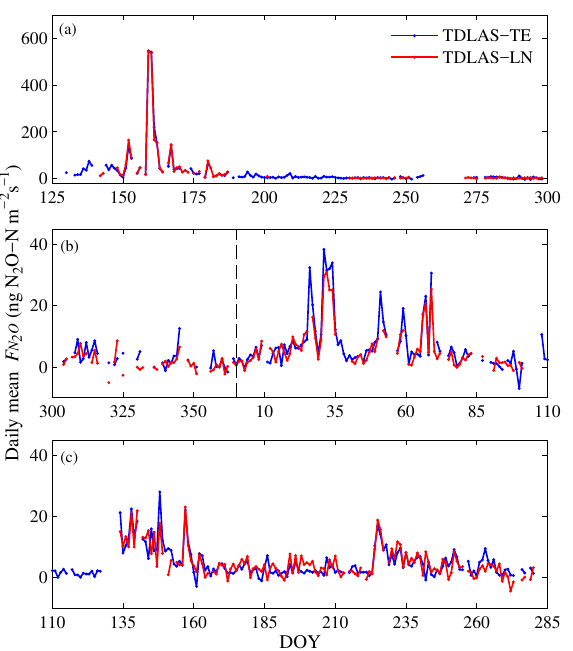
Figure 3. Mean daily fluxes of N 2 O–N measured by each ana- lyzer. Panel (a) shows the period of high N 2 O fluxes in the post- fertilization period of 2015 and the fluxes measured throughout the growing season. Panel (b) shows the fluxes measured during the post-harvest period of 2015 and winter of 2016. The dotted line in panel (b) demarcates the separation between years 2015 and 2016. Panel (c) shows fluxes measured from early spring to the end of the growing season of 2016.